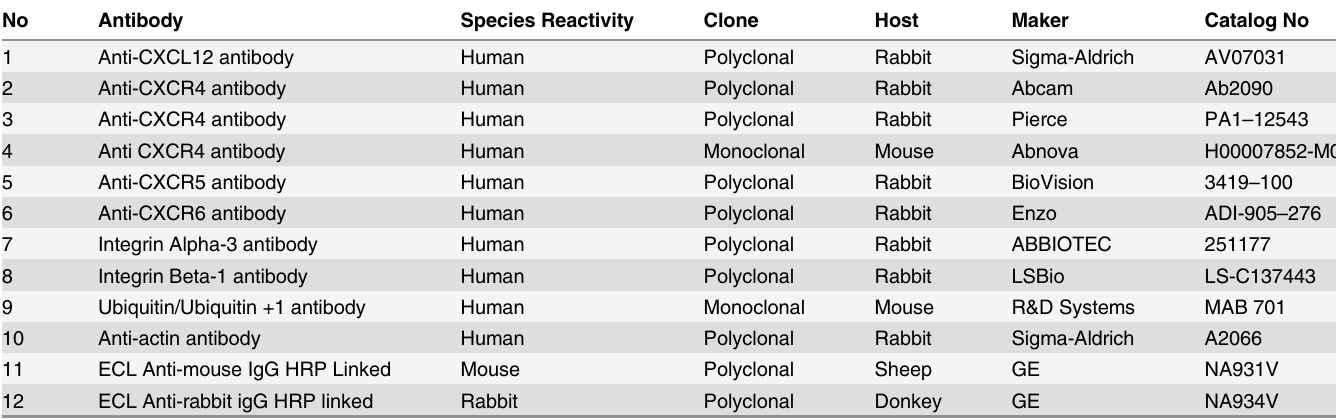
Table 2. Antibodies used in western blot